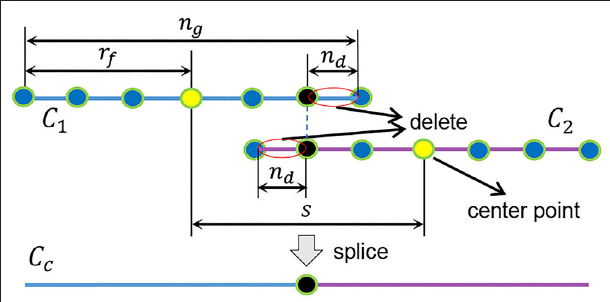
FIGURE 3 | Merge multiple curves ( C 1 and C 2 ) into one curve( C c